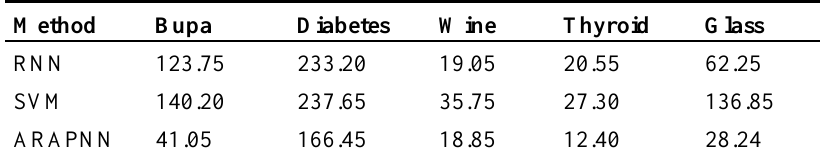
Table 12 . Comparison of the averaged number of prototypes selected by RNN, SVM, and ARAPNN [38].